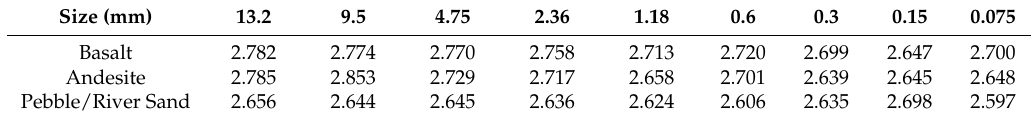
Table 3. Apparent densities of coarse and fine aggregates (Unit: g/cm 3 ).